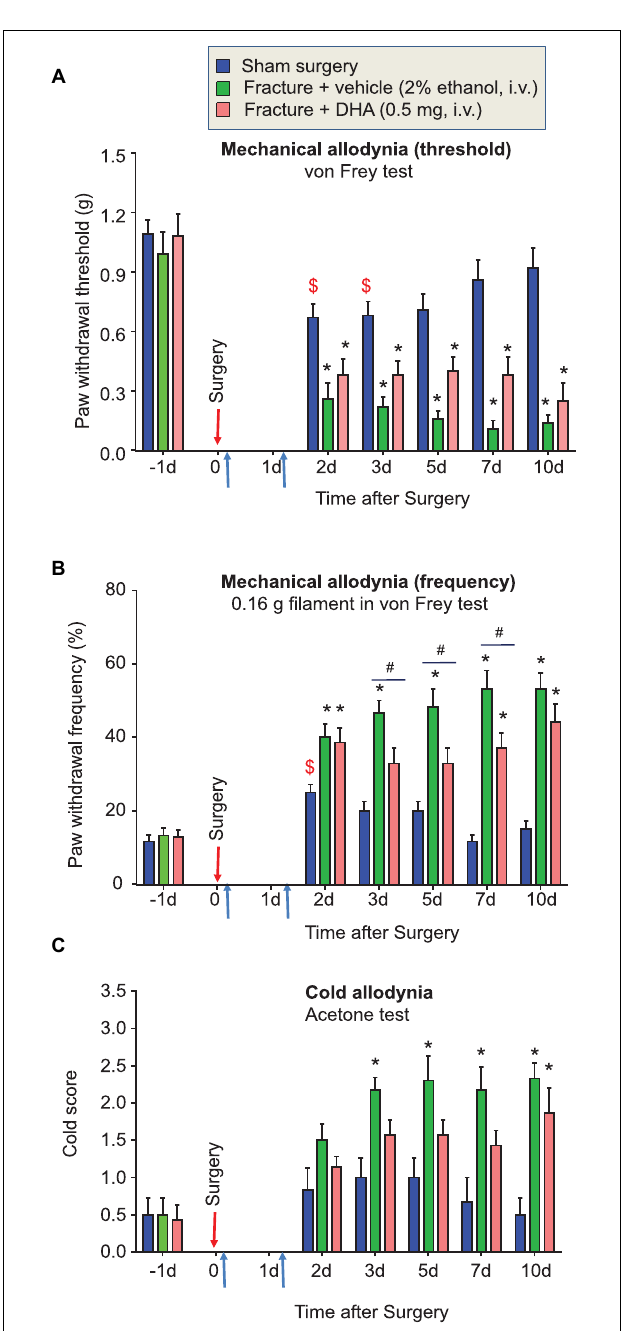
FIGURE 1 | Effects of sham surgery, bone fracture, and perioperative DHA treatment on the development of fPOP. Development of mechanical allodynia, assessed by paw withdrawal threshold (A) and paw withdrawal frequency to 0.16 g filament (B) in von Frey test, after sham surgery, tibial bone fracture, and perioperative treatment of DHA (0.5 mg, 100 µ l, i.v.), given 10 min and 24 h after bone fracture surgery (indicated by blue arrows). (C) Development of cold allodynia, assessed by cold response scoring in the acetone test, after sham surgery, tibial bone fracture, and the perioperative DHA treatment after bone fracture surgery (indicated by blue arrows). $ P < 0.05, one-way ANOVA in Sham group vs. baseline; ∗ P < 0.05 vs. Sham surgery; # P < 0.05, fracture vs. fracture + DHA; two-way ANOVA followed by Bonferroni test, n = 6–7 mice/group. Data are presented as mean ±